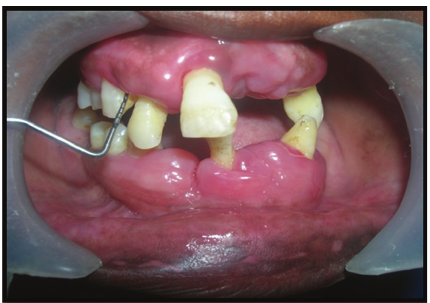
Figure 1: Female patient with gingival enlargement (preoperative view).